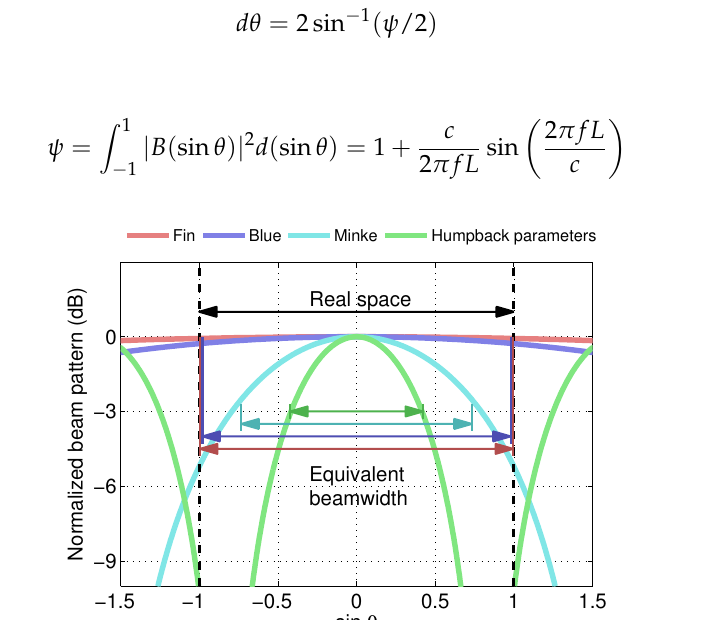
Figure 1. Beam patterns of two-element coherent array steered at broadside given baleen whale acoustic parameters given in Table